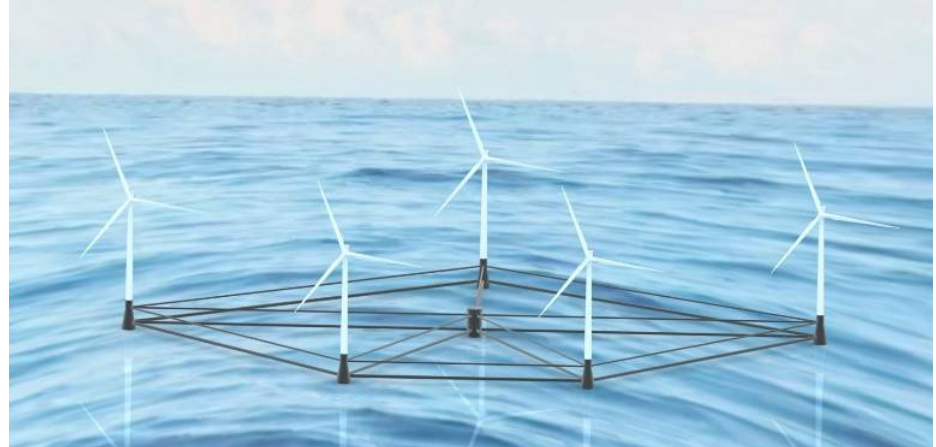
Figure 15. Offshore floating multi-wind turbine platform.